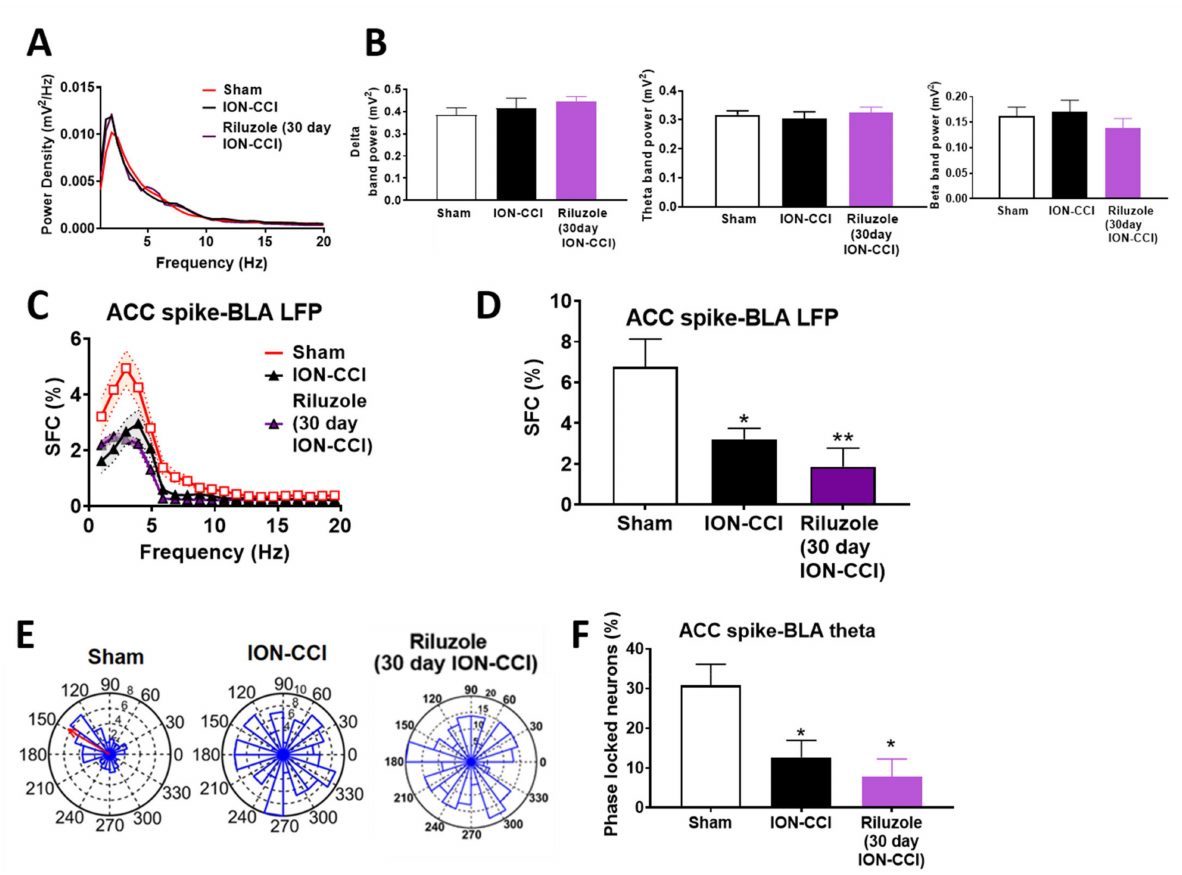
Figure 4. Reduction of spike-field coherence and phase-locking between ACC spikes and BLA theta in ION-CCI rats. ( A ) Power spectral density analysis in the frequency range from 0–20 Hz of the LFP in 30-day ION-CCI, sham-operated rats, and riluzole-treated 30-day ION-CCI rats. ( B ) Power spectral density showing the averaged delta band power (0.5–4 Hz), averaged theta band power (4–10 Hz), and averaged beta band power (10–20 Hz) in the ACC region in ION-CCI and sham-operated rats. ( C ) The SFC distribution of ACC single units as a function of frequencies in sham rats (n = 6), ION-CCI rats (n = 6), and riluzole-treated ION-CCI rats (n = 4). Shadow areas represent SEM. ( D ) Averaged SFC values in theta band show reduction of theta band SFC in ION-CCI rats compared to that in the sham rats. ( E ) Examples show polar-histograms of the ACC spike timing-BLA theta phase distribution of a single unit recorded in the ACC in one sham rat, a single unit in ACC of one ION-CCI rat, and a single unit of one riluzole-treated 30-day ION-CCI rat. The red arrow in the polar-histogram of sham rat represents angle of the mean resultant vector. ( F ) Averaged percentages of phase-locked neurons show a significantly decrease in ACC single-unit spikes phase-locking to BLA theta band field potential in ION-CCI rats and riluzole-treated ION-CCI rats compared to that in sham rats. Results are shown as mean ± SEM (* p < 0.05, ** p < 0.01 by one-way ANOVA followed by Bonferroni’s adjusted t